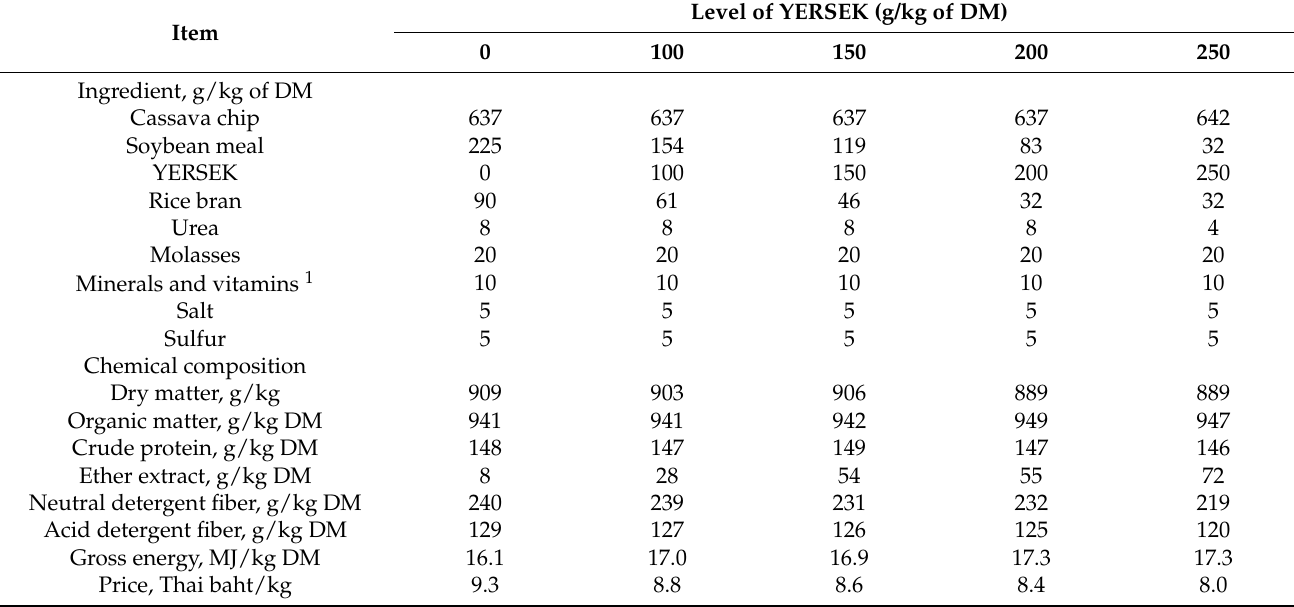
Table 1. Ingredient and chemical composition of concentrate